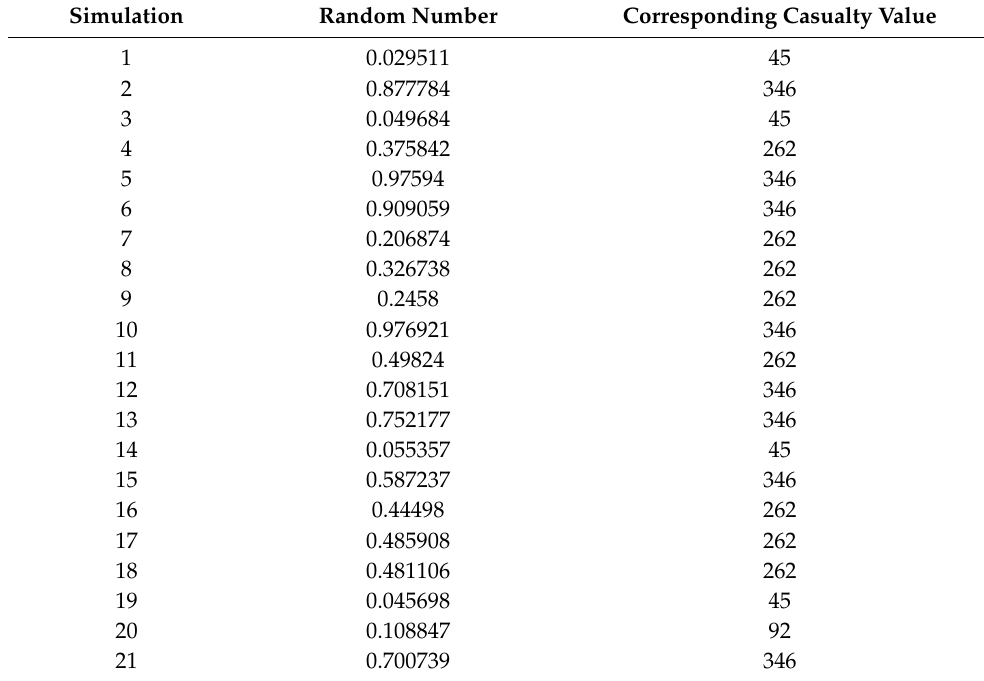
Carlo method: 5000 randomly selected casualty numbers from the five-year Boeing 737-Max data set. The mean from the simulations assigned casualty numbers of 5000 iterations (N) can be found by using the basic mean calculation formula: ∑ X mean = X i /N Table 2. Monte Carlo simulations